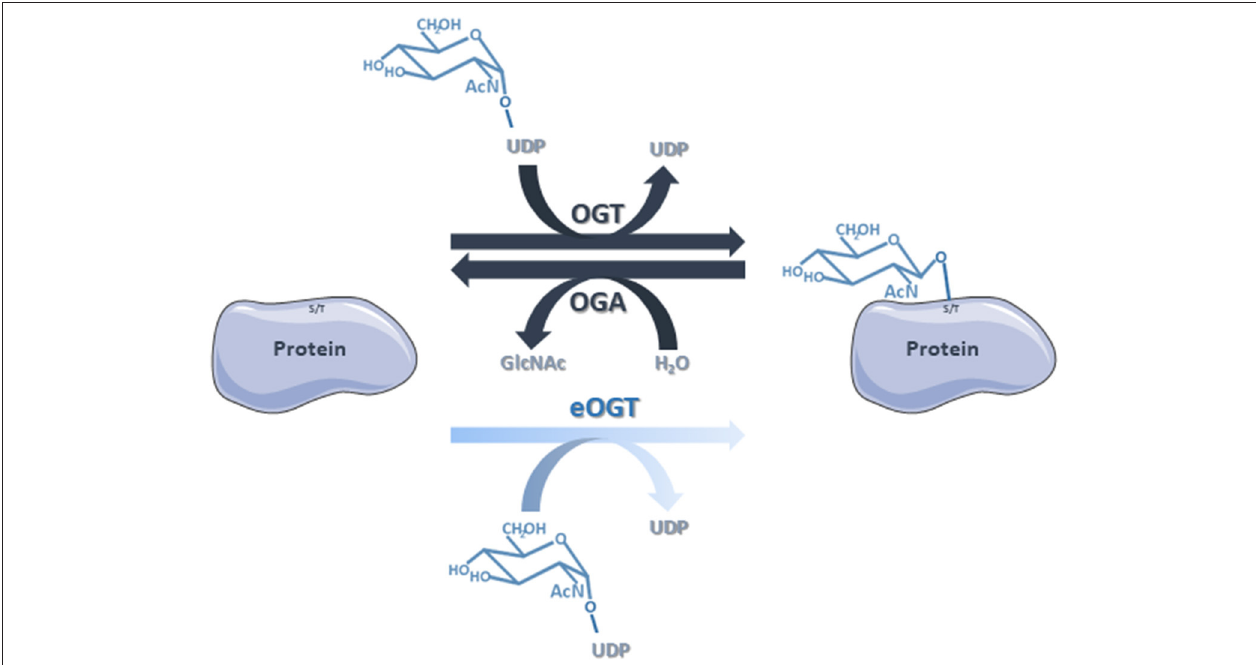
FIGURE 6 | The classical O -GlcNAcylation cycling is managed by OGT that transfers the GlcNAc group from the donor UDP-GlcNAc to the target proteins, and OGA that removes the residue by hydrolysis. Nevertheless, we do not rule out that some of the proteins identified in this study are substrates of eOGT. eOGT is located in the endoplasmic reticulum where it glycosylates secreted and membrane proteins, and is suggested to modify proteins confined within intracellular compartments. In contrast to O -GlcNAcylation driven by OGT/OGA, it is unlikely that eOGT-catalyzed O -GlcNAcylation is versatile.